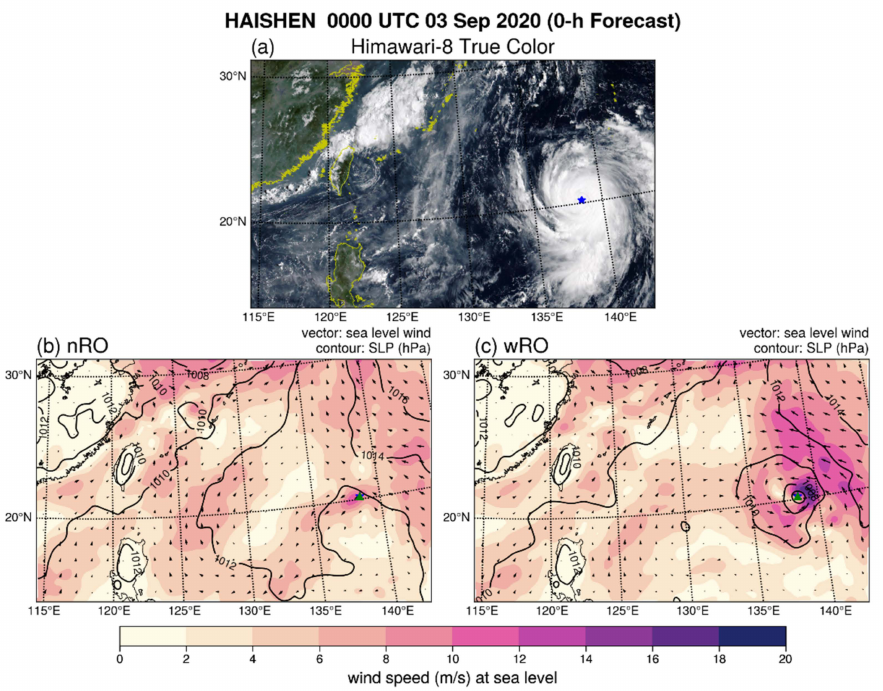
Figure 11. ( a ) True color image from Himawari-8, ( b ) the initial condition within nRO and ( c ) wRO of Typhoon Haishen at 0000 UTC on 03 September 2020. The green stars denote the central positions of the best track at this time.